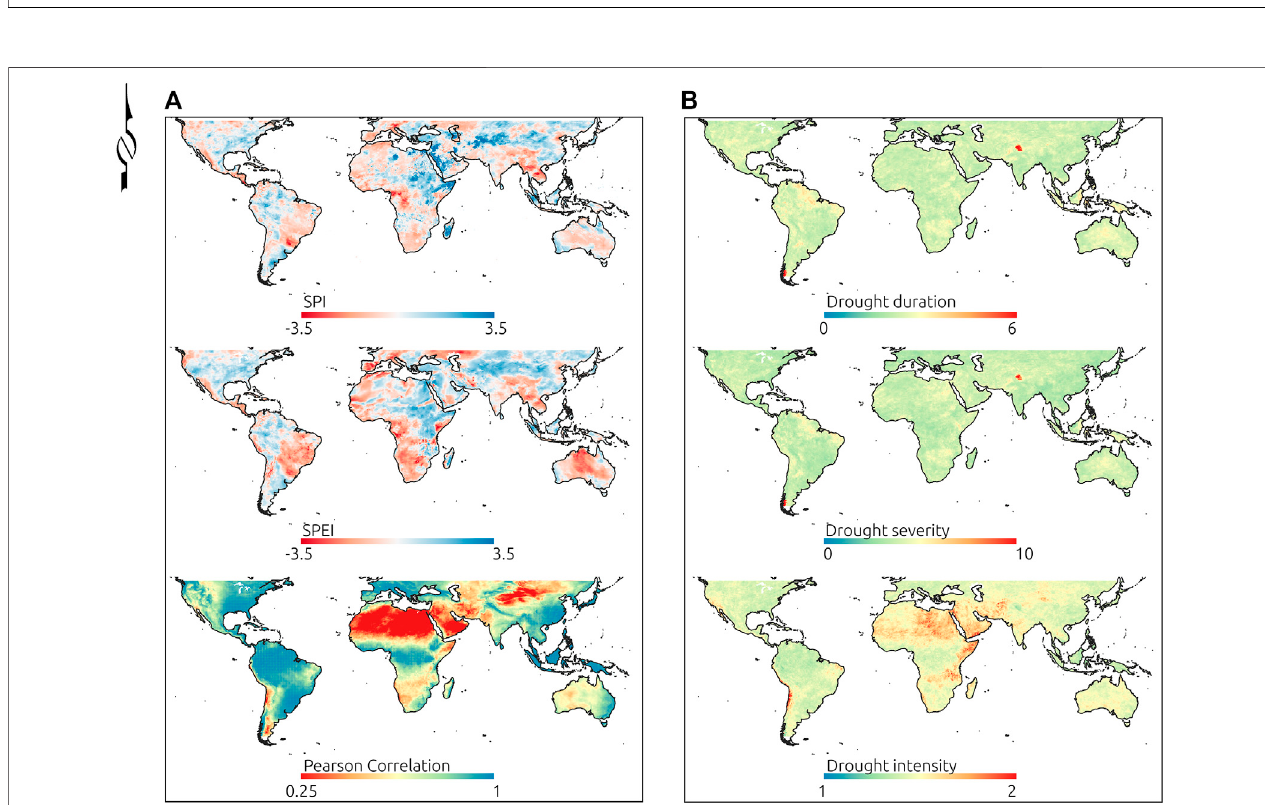
FIGURE 4 | SPI — SPEI example maps for July 2019 and correlation between the entire time series of both indices (A) and 3-month SPEI drought characteristics (B) .